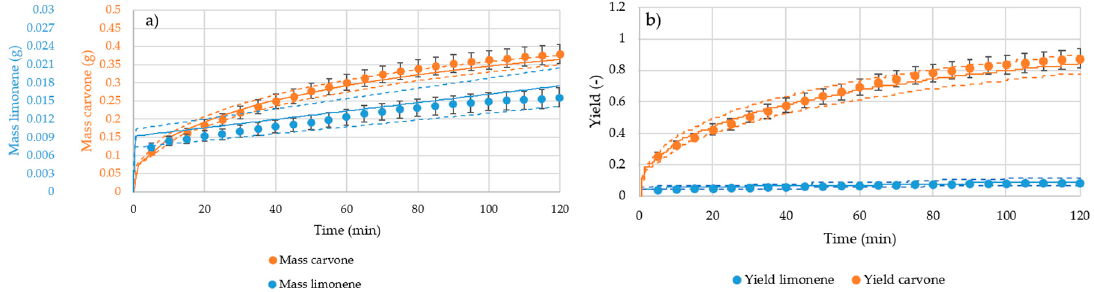
Table 6. Parameters of the accuracy and precision study of the lavender model. Model Parameter Unit Figure 14. Precision and accuracy for mass ( a ) and yield ( b ) of the caraway system. Figure 14. Precision and accuracy for mass (a) and yield (b) of the caraway system. In the experiments at the central point, a mass of 378 ± 16 mg carvone and a mass of 16 ± 1 mg limonene are obtained. This corresponds to a yield of 87 ± 6% carvone and a yield of 9 ± 1% limonene. The simulation calculates a mass of 364 mg for the carvone and a mass of 17 mg for the limonene. This corresponds to a yield of 84% of the carvone and a yield of 9% of the limonene. The precision of the simulation is ± 13 mg for the mass of carvone, ± 3 mg for the mass of limonene, ± 6% for the carvone yield and ± 2% for the limonene yield. The simulation results of the carvone have a higher precision than the results of the experiments carried out at the central point of the test plan. The simulation results of limonene are less precise than the experiments. The prediction inaccuracy doubles and increases from 7% to 16%. This is mainly due to the low extracted mass and the low water solubility of limonene. These e ff ects have already caused problems when determining model parameters. Despite less precision, the model gives a good prediction of the simulation results in the case of the caraway. For the mass and the yield of the lavender system, the accuracy and precision are displayed in